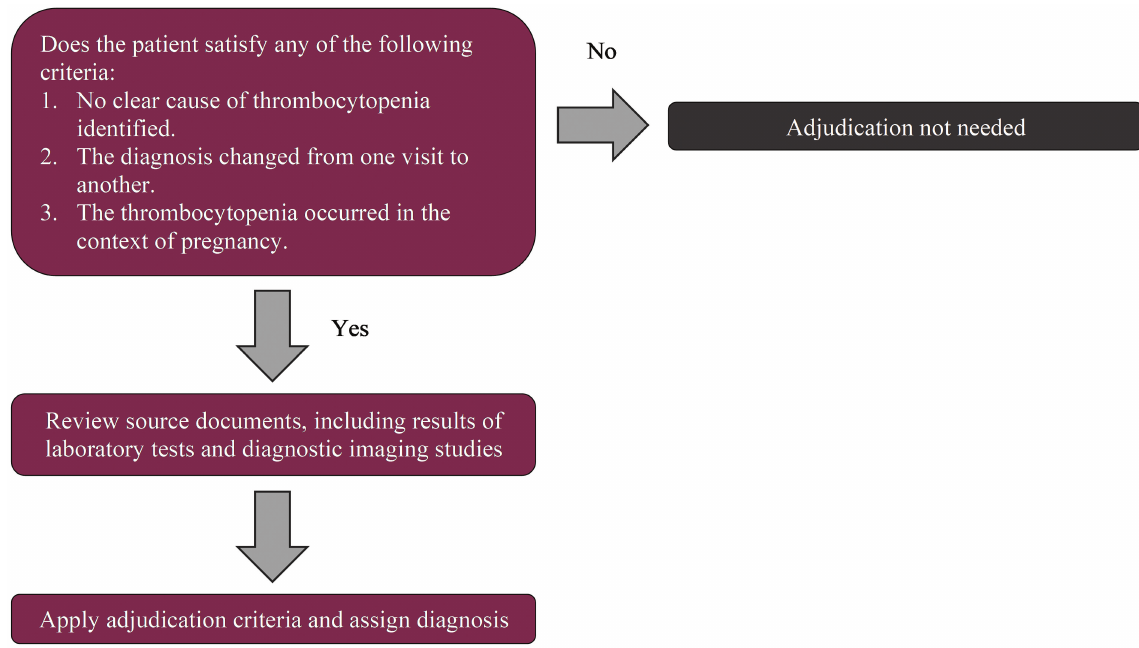
Fig. 1 Flowchart demonstrating the application of the adjudication process for patients with thrombocytopenia in a research context.